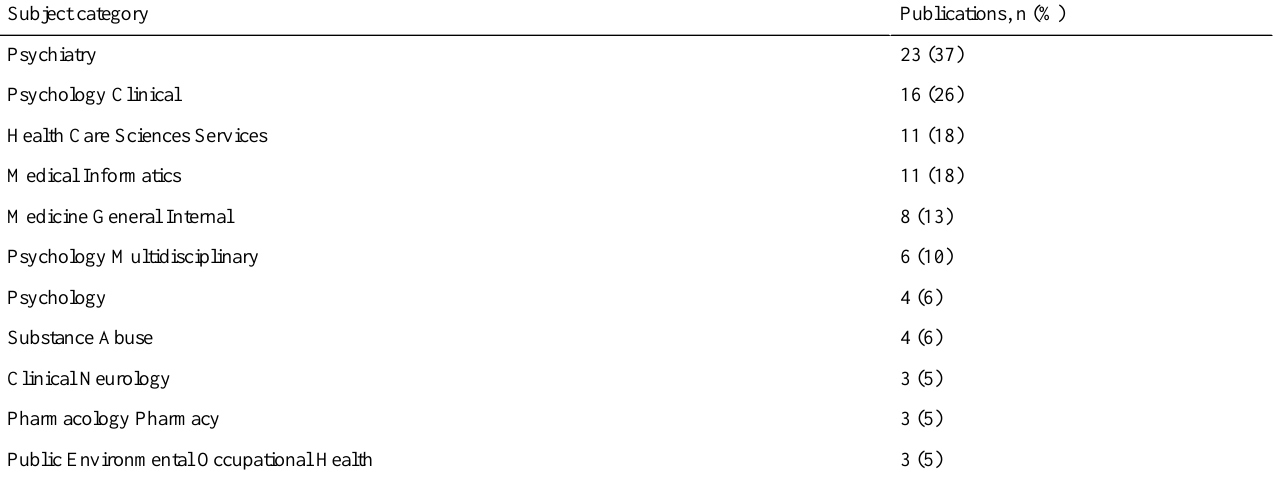
Table 1. Publications in the top Web of Science subject areas from 2010 to 2019 (N=64).